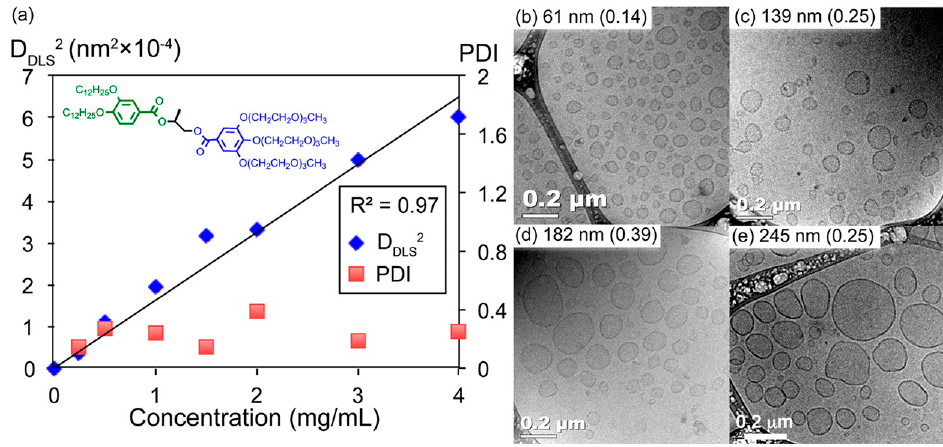
Figure 11. Variation of the diameter of dendrimersomes as a function of the final JDs concentration. ( a ) Square diameter ( D DLS2 )–concentration relationship of the dendrimersomes formed by (3,4)12G1- I-PPD-(3,4,5)-3EO-G1-(OCH 3 ) 3 . Representative cryo-TEM images of the dendrimersomes with the indicated diameter ( D DLS2 , in nm) and polydispersity index (PDI, in parentheses) at a final concentration of: ( b ) 0.25 mg/mL; ( c ) 1 mg/mL; ( d ) 2 mg/mL; and ( e ) 4 mg/mL. Copyright American Chemical Society, reprinted from ACS Nano 2014